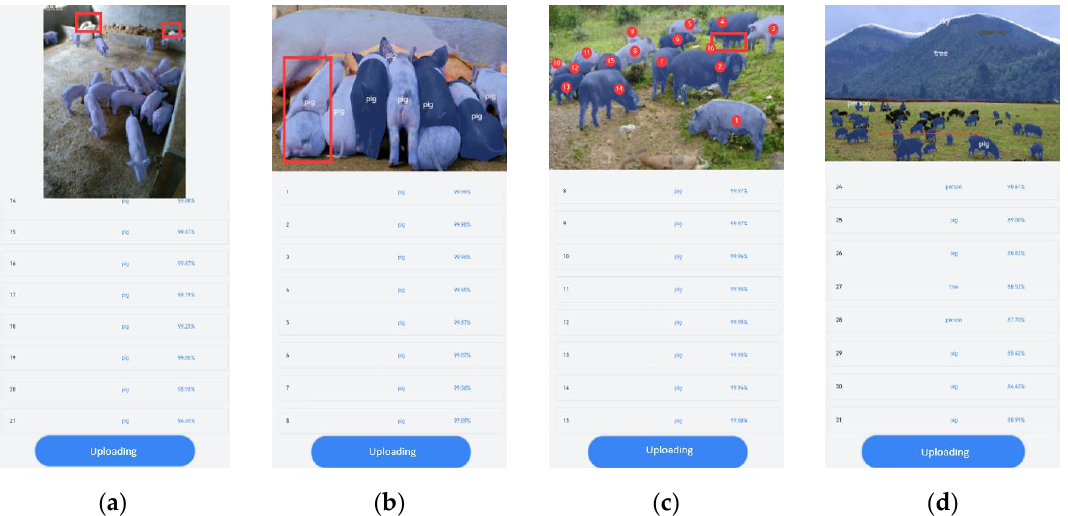
Figure 15. Error examples in counting applications: ( a ) missing segmentation; ( b ) mis-segmentation; ( c ) missing count; ( d ) pressure test.